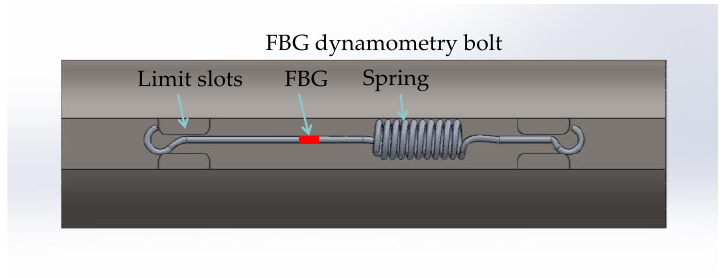
Figure 3. Structure diagram of the limit slot for the FBG dynamometry bolt.